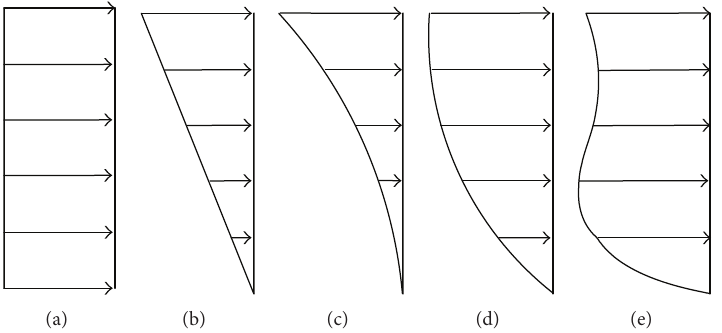
Figure 4: Load patterns for performance analysis of transmission tower: (a) rectangular, (b) inverted triangular, (c) first mode, (d) power law, and (e)